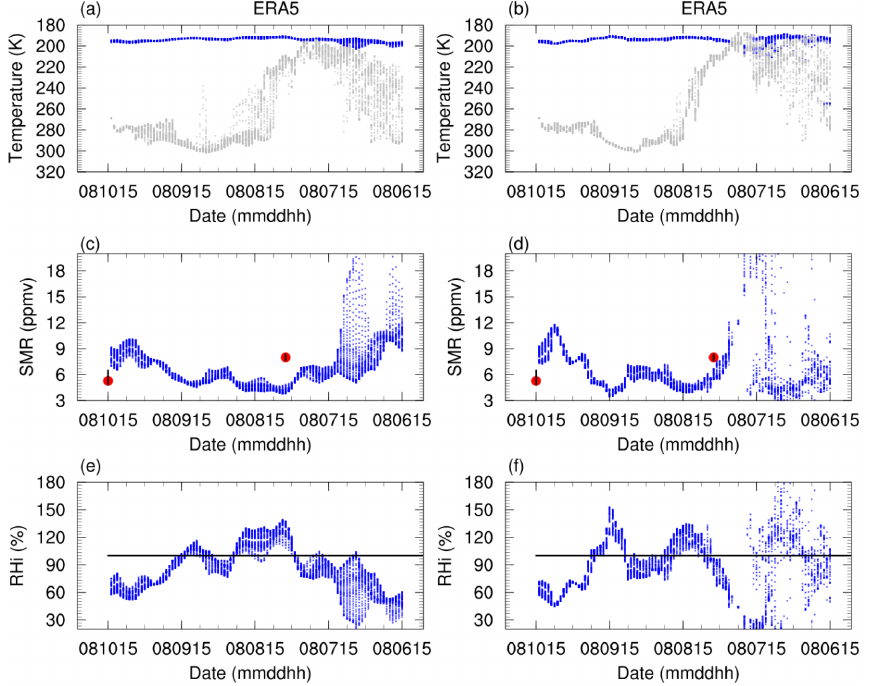
Figure 15. As Fig. 8 but for the case on 10 August